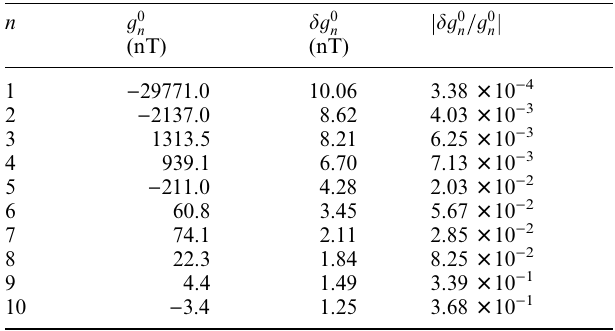
Table 2 . Values of g 0 model GSFC 1990D (after Langel et al ., 1992)